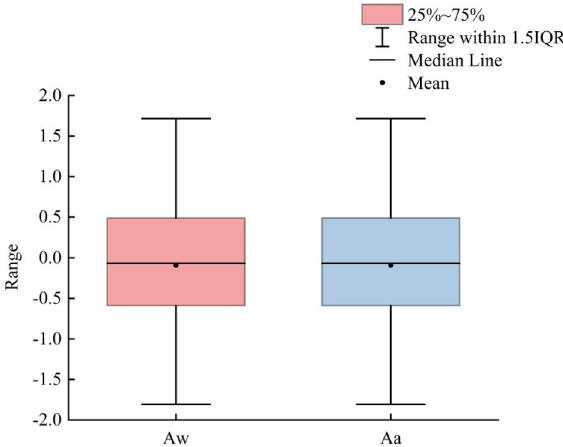
Figure 5. Directionality of the rill